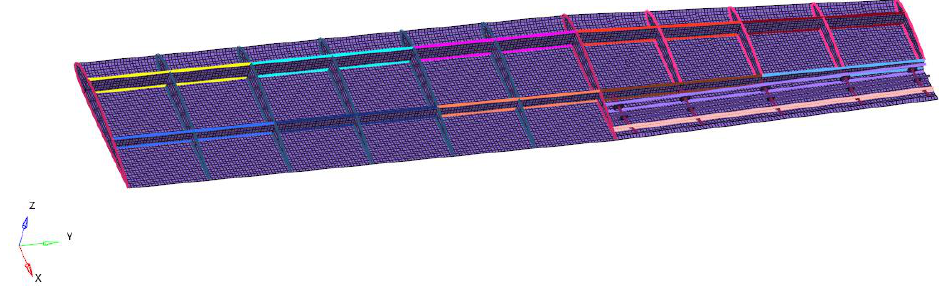
Figure 14. Finite element mesh of the wing (with the upper skin hidden).